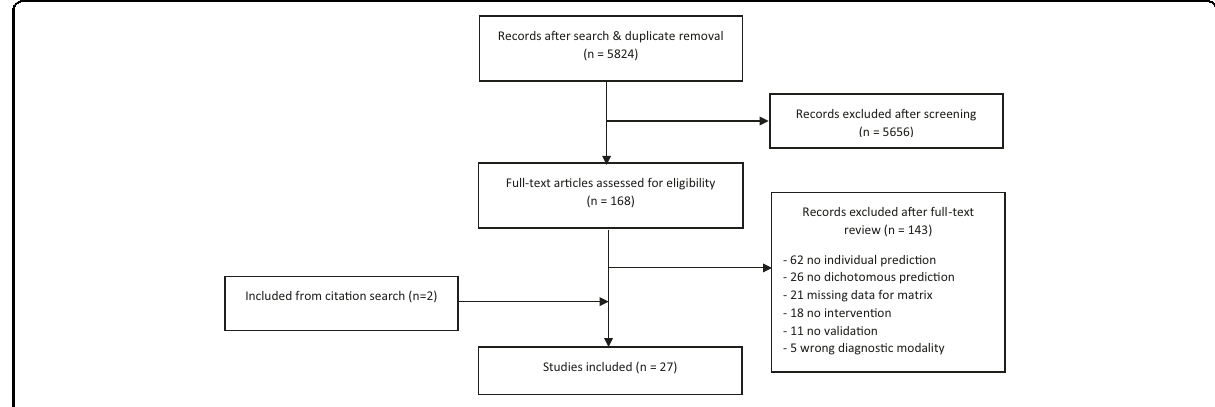
Fig. 1 Flow diagram of the study inclusion process. n